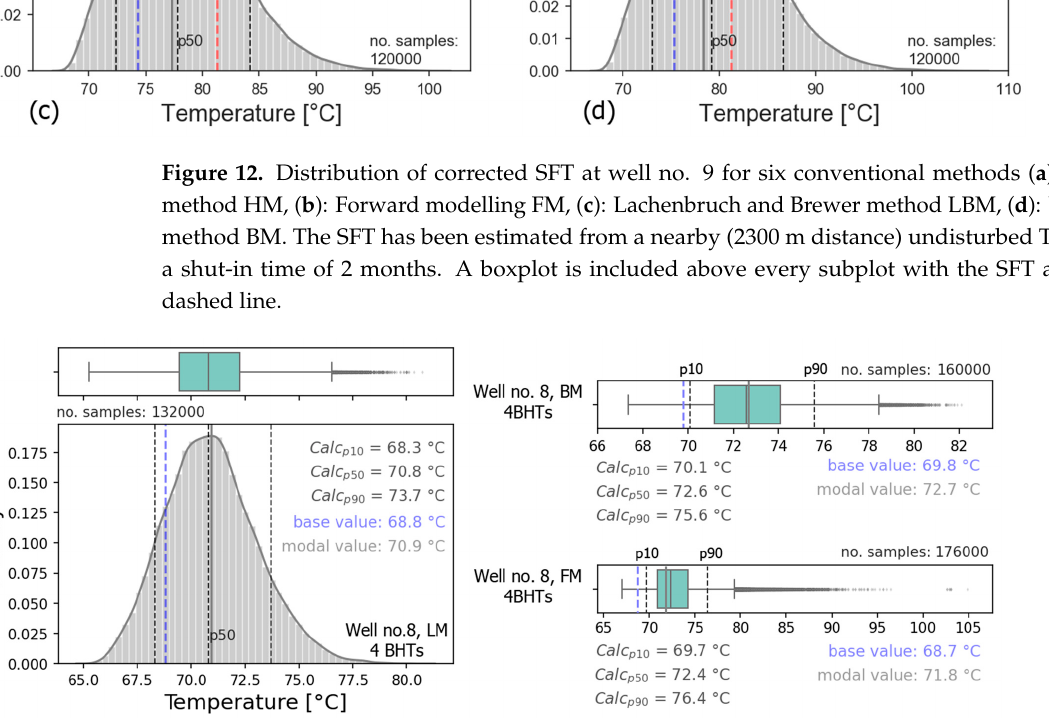
Figure 13. Distribution of corrected SFT at well no. 8 for the three corrections: linearization method LM (left), Brennand’s method BM (middle), and forward modeling FM (right). A boxplot is included above every subplot. Due to an incomplete wireline TLog, there is no SFT information available at the depth of the BHT measurements and therefore it is not shown in the plots. The uncertainty of the LM correction scheme must therefore be evaluated by comparing the distribution of results with the other methods (BM and FM) that were previously quantified on complete data sets including known SFT.